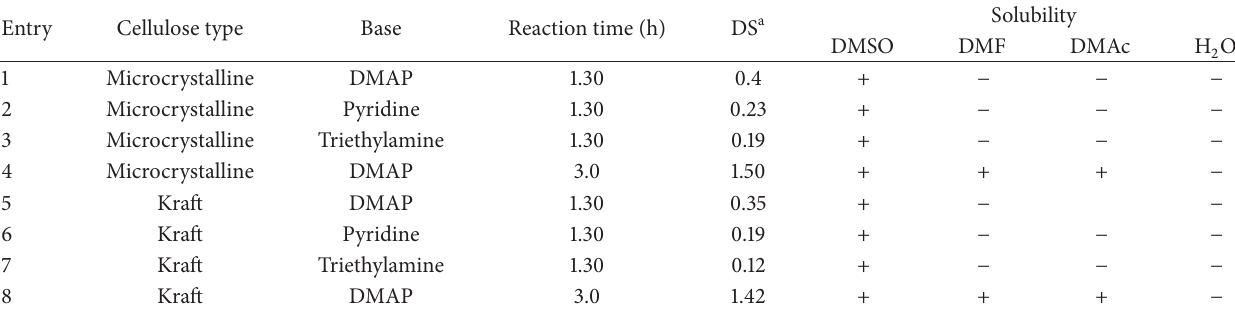
Table 1: Reaction conditions, DS, and solubility for obtained cellulose p